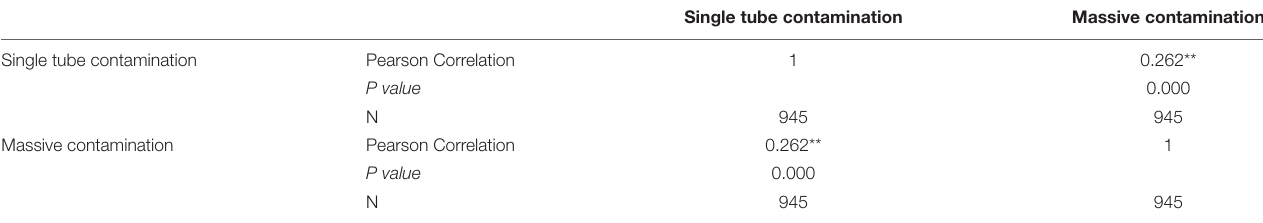
TABLE 2 | Correlation between single tube contamination and massive contamination.